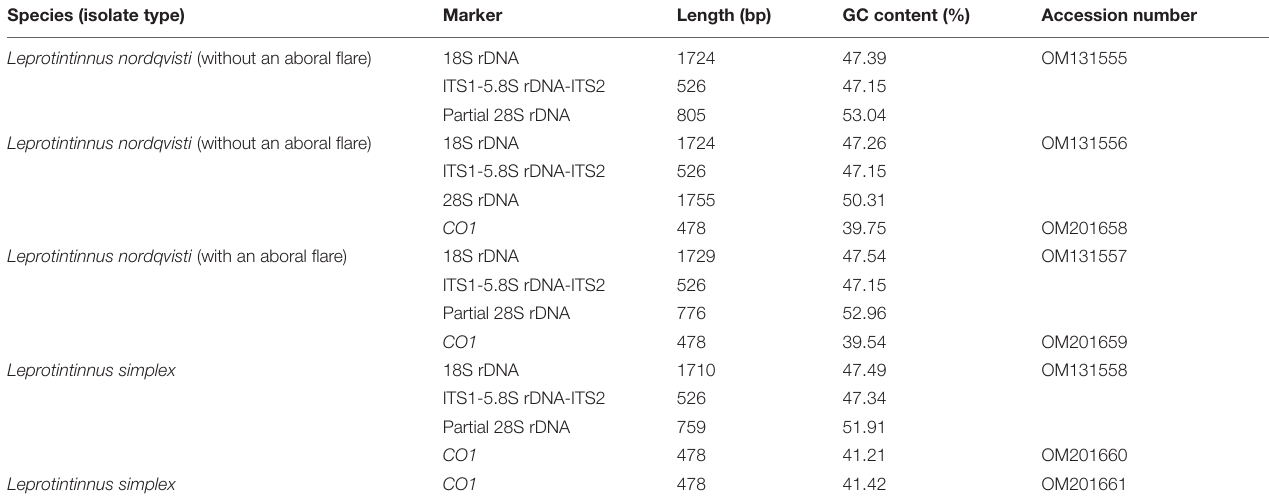
TABLE 2 | Gene sequences obtained in this study. Species (isolate type) Marker Length (bp) GC content